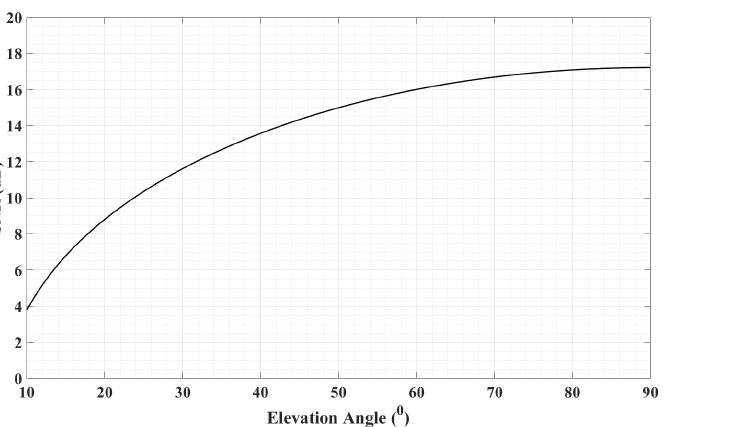
Figure A1. SNR of the LEO satellite link for the range of elevation angle varying from 10 ◦ to 90 ◦ . We observe that the SNR is decreasing as the elevation angle is decreasing. This is expected as with lowering elevation angle, as the path length through the channel increases leading to higher absorption and free-space path loss. It should be noted that for a SNR of 4 dB, the bit-error rate (BER) of a Quadrature PSK (QPSK) would be 1.53 × 10 − 7 for the convolution coding with soft decision and code rate of 2/3. The simulation results have been shown upto the elevation angle of 10 ◦ as for the next-generation of LEO satellite networks, there will thousands of satellite in the orbit and the handover will be done at higher elevation angles to maintain high link quality